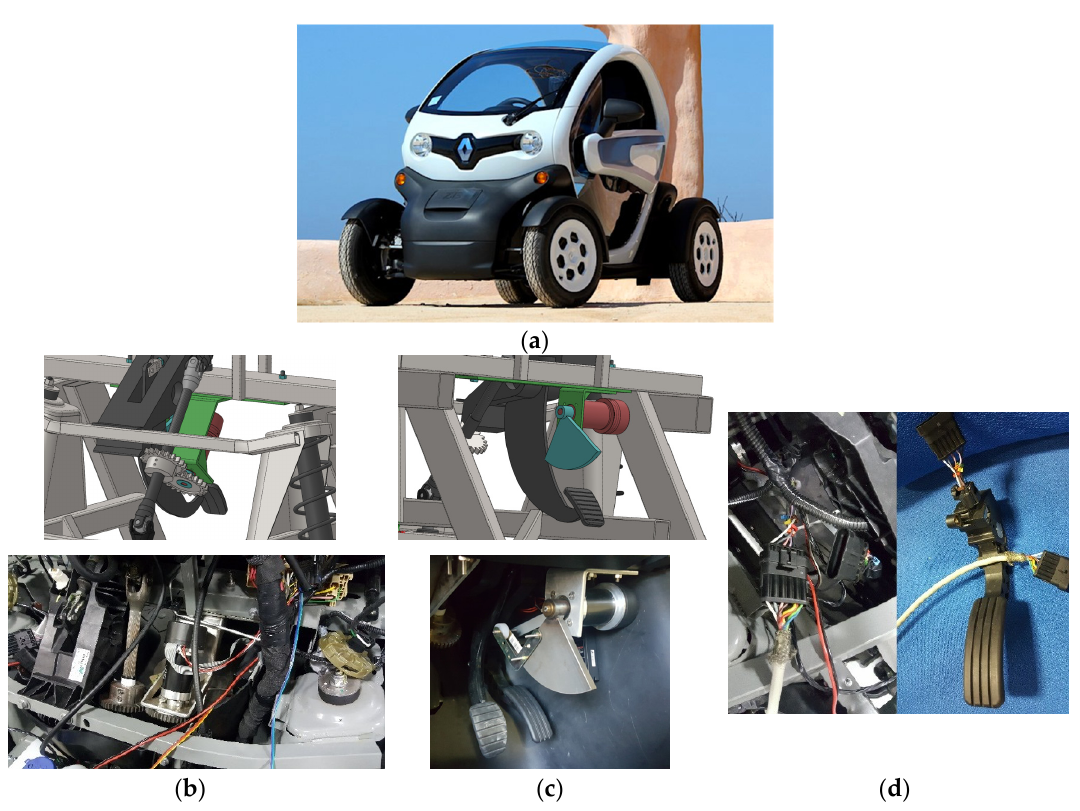
Figure 1. Automation of driving elements. ( a ) Renault Twizy; ( b ) steering modification; ( c ) braking system modification; ( d ) throttle modification.